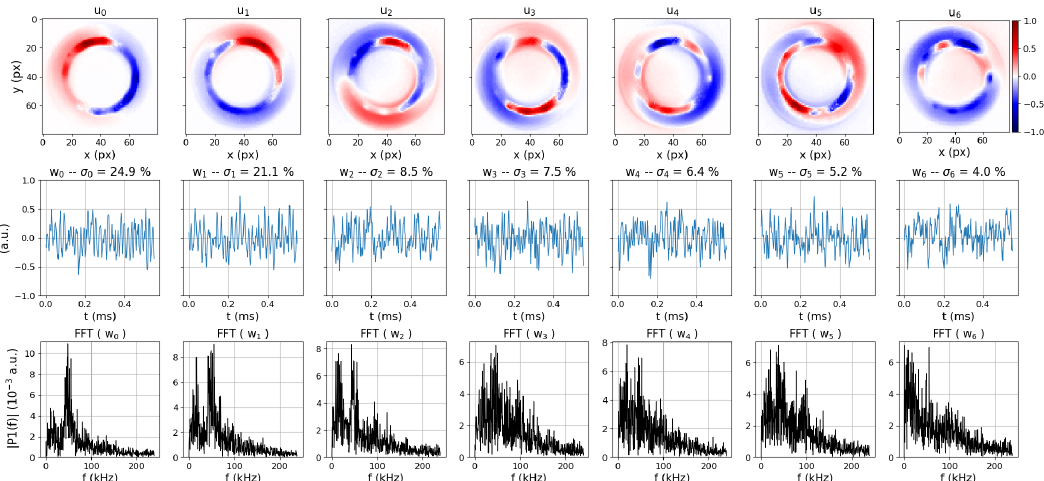
Figure 7. Under-emissive regime : POD analysis of the front videos with a discharge voltage U d = 200 V, a mass flow rate Q = 1.8 mg · s − 1 , a cathode heating current I H = 17.50 A ( I H / I H , crit = 0.95) and a acquisition frequency of F fps = 480 kfps. ( Top ) Spatial POD modes u i ; ( Middle ) corresponding temporal POD modes w i with their singular value λ i given as σ i = λ 2 expressed as a percentage; and ( Bottom ) corresponding FFT.